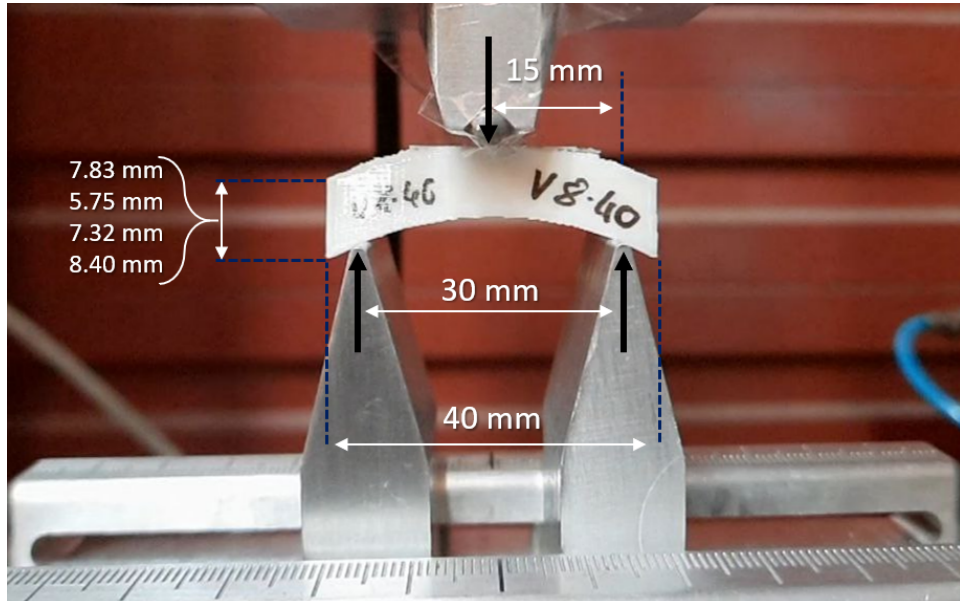
Figure 2. Experimental setup for 3-point flexural tests with Instron Universal Mechanical Testing Machine 3366. The nominal span and thickness of specimens are indicated in the figure, while the nominal depth was 10